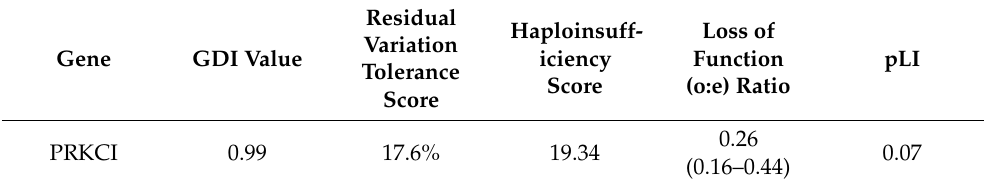
Table 3. Genetic variation tolerance of PRKCI with human gene damage index score (GDI), residual variation tolerance score, haploinsufficiency score (%HI), observed to expected (o:e) ratio, and loss of function intolerance probability (pLI) values.